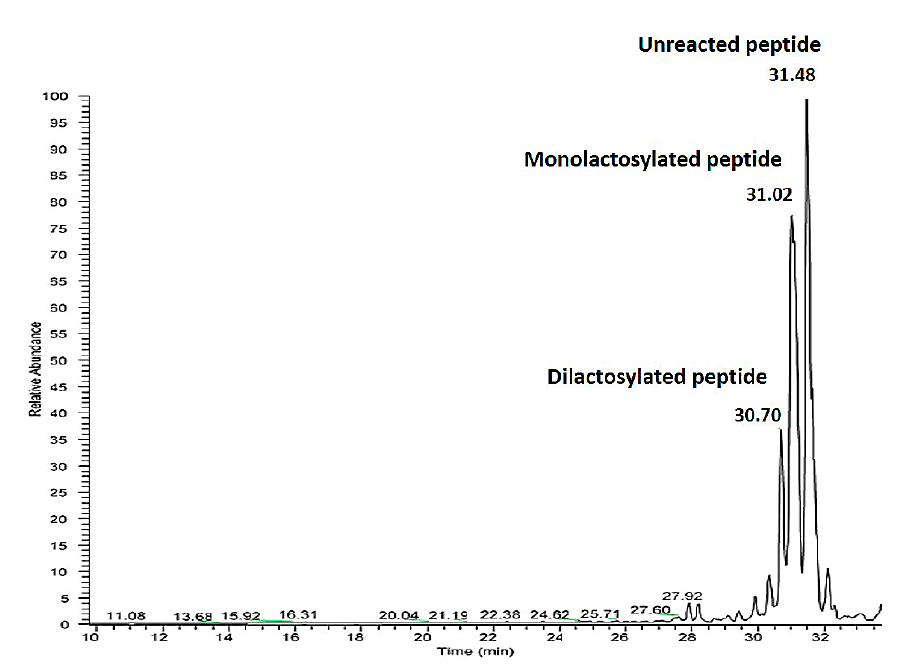
Figure 2. UHPLC-MS / MS analysis of the reaction mixture obtained adopting the conditions described in Table 5 line 5. TIC (total ion current) profile of reaction mixture obtained. The relative abundance is on the y axis, while time is on the x axis.